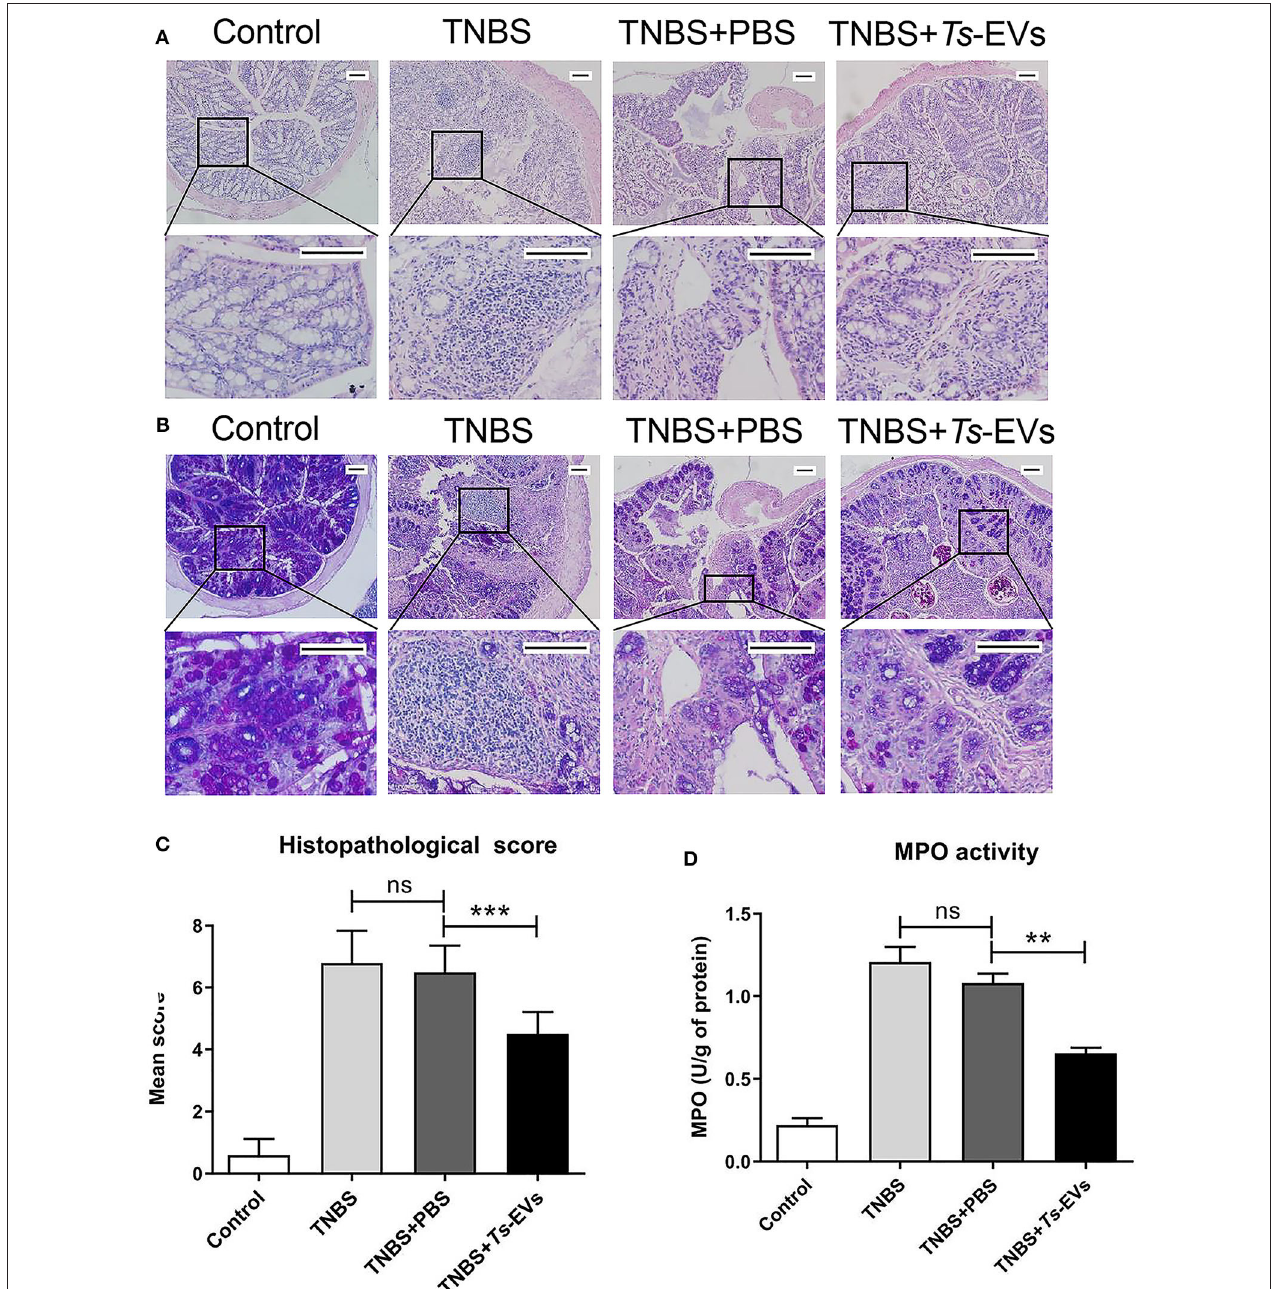
FIGURE 3 | Ts -EVs reduced histopathological signs of colon damage and myeloperoxidase (MPO) activity in TNBS-induced colitis. (A) Colon tissue samples were examined after hematoxylin and eosin (H&E) staining (magnification 100 × and 400 × , scale-bars = 100 µ m). (B) Colon tissue samples were examined after periodic acid Schiff (PAS) staining (magnification 100 × and 400 × , scale-bars = 100 µ m). (C) Histopathological scores based on the extent of inflammation, inflammatory cell infiltration, extent of crypt damage and loss of goblet cells, as described in methods. (D) Myeloperoxidase (MPO) activity was determined by a spectrophotometric method. Results are shown as mean ± SD of each group ( n = 10). Statistical analysis was performed with one-way ANOVA followed by Tukey’s multiple-comparison test. ** p < 0.01, *** p < 0.001.